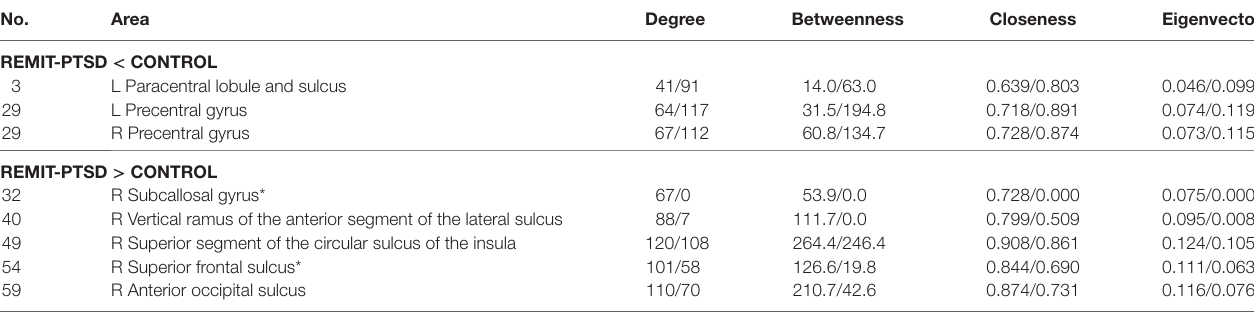
TaBle 2 | Centrality between-group comparisons: REMIT-PTSD (lifetime but no current PTSD group) versus CONTROL (control group with trauma exposure). no.